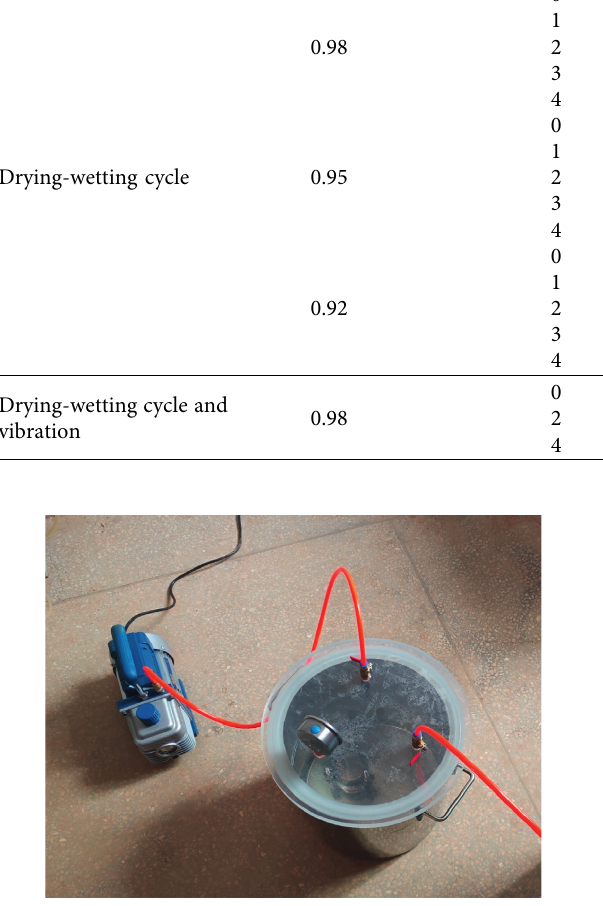
Figure 5: Devices used in the wetting